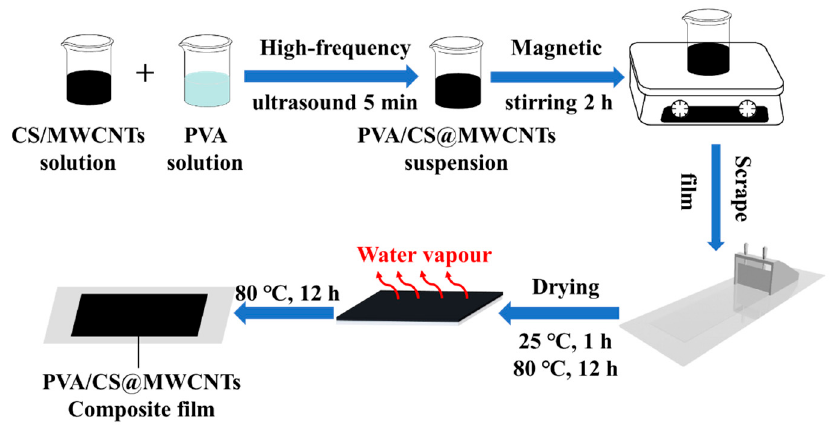
Figure 1. Schematic of the fabrication of sandwich-structured flexible PVA/CS@MWCNTs composite